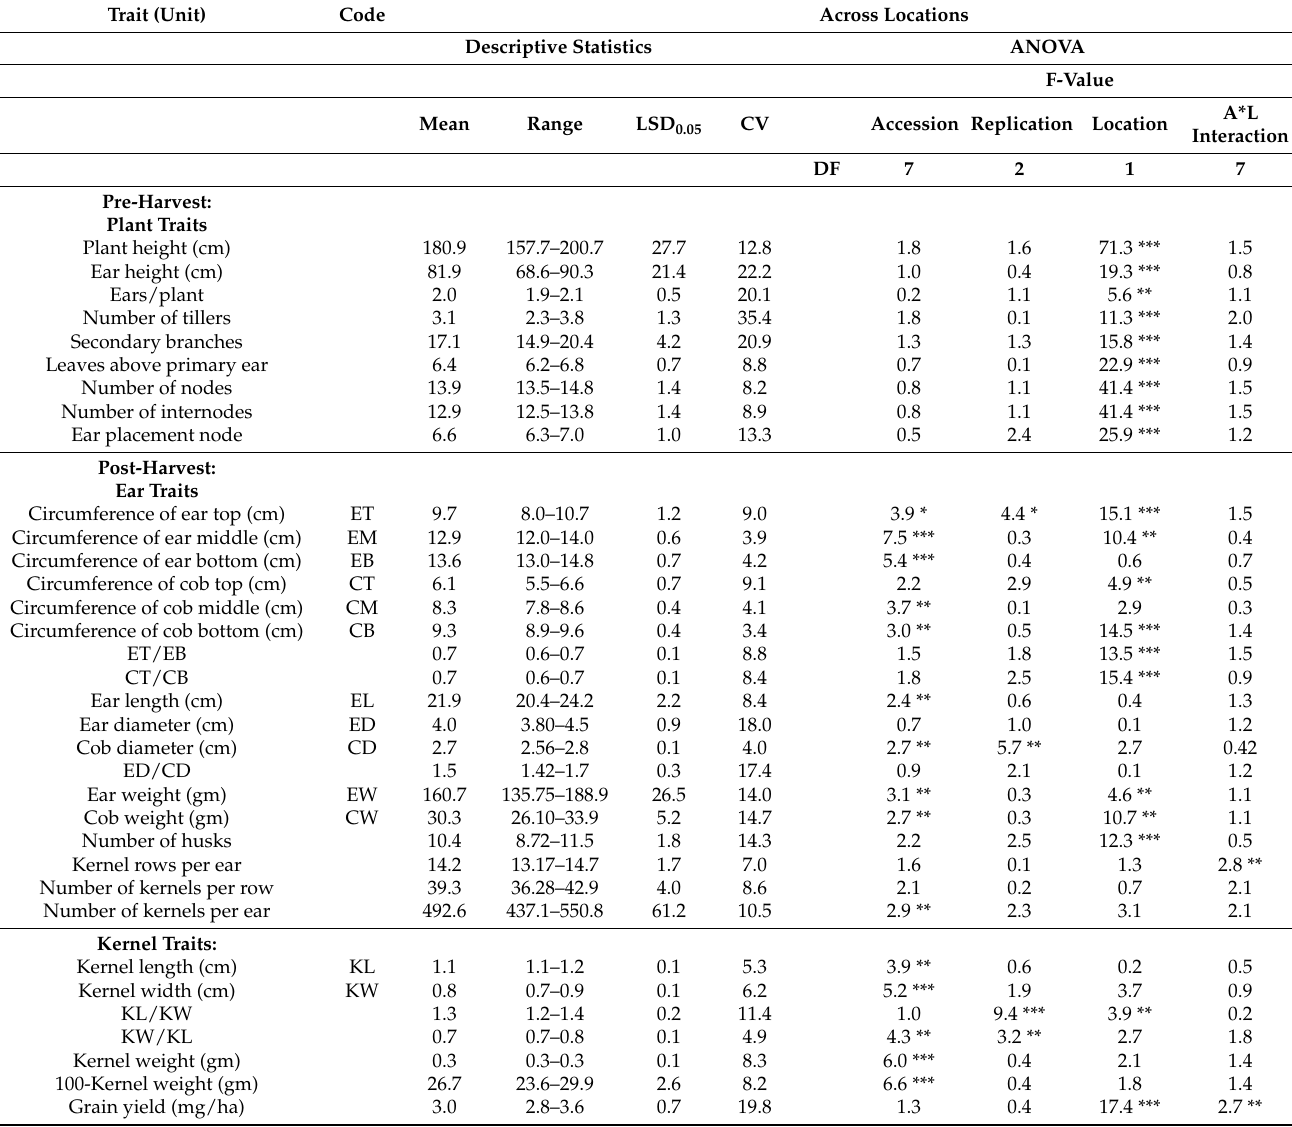
Table 1. Descriptive statistics and analysis of variance (ANOVA) for all pigmented maize landraces evaluated by pre-harvest plant and post-harvest ear, and kernel traits evaluated across Alcalde and Los Lunas. Level of significance expressed is * p < 0.05, ** p < 0.01; *** p <